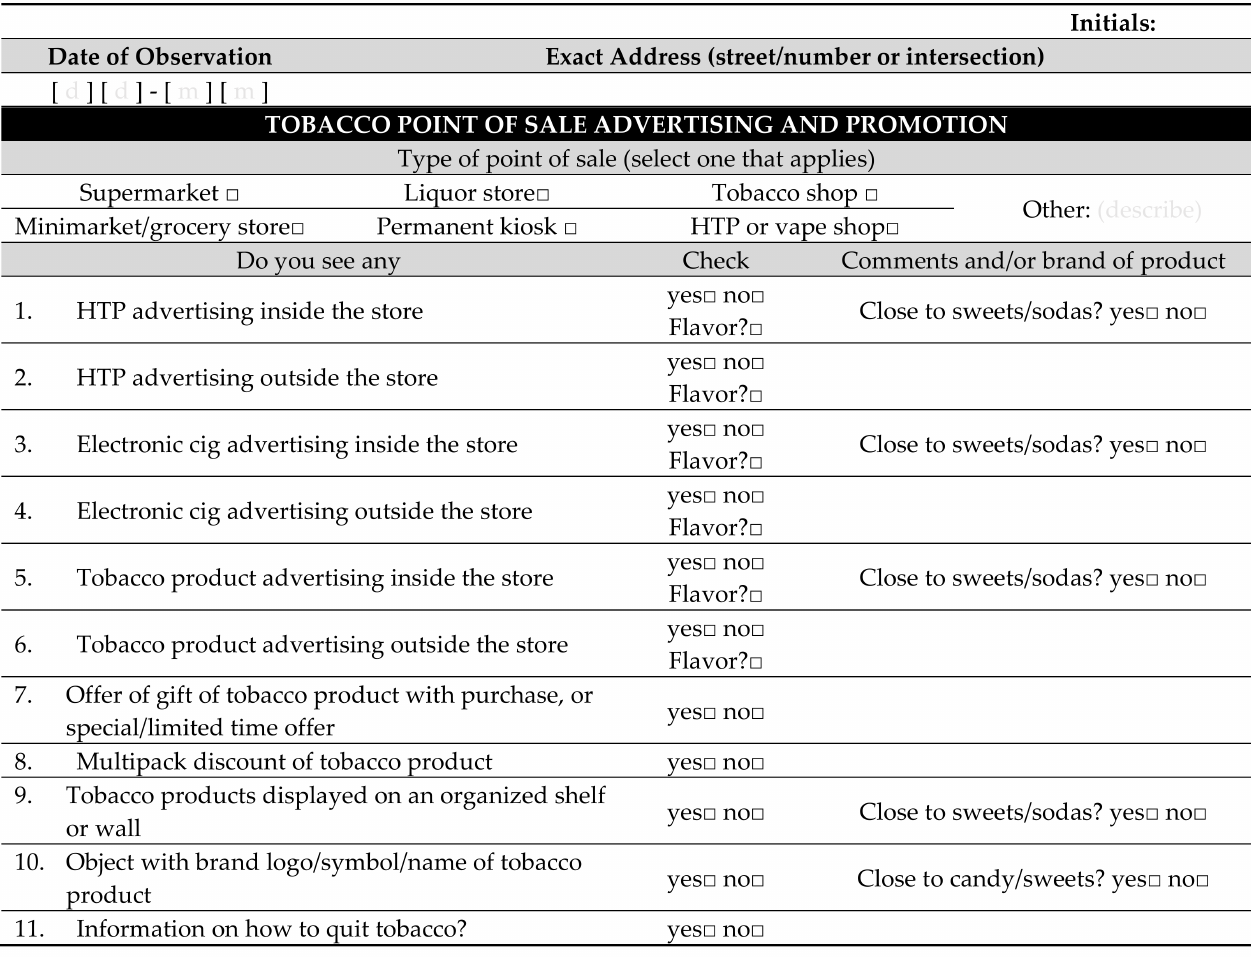
Figure 2. Standardized observation questionnaire used during the POS